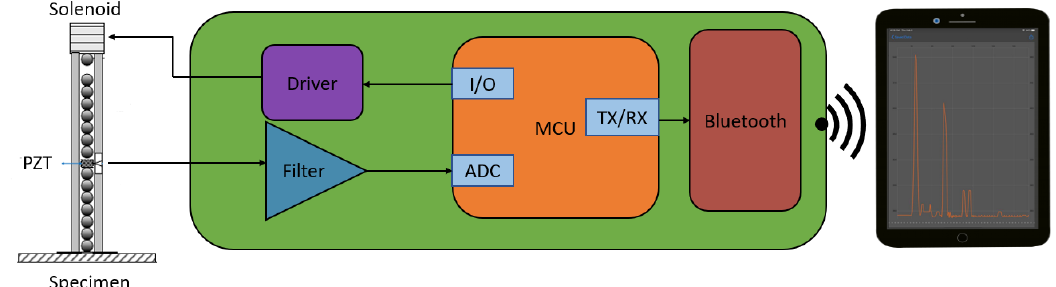
Figure 2. Schematics of the overall HNSW wireless sensor node. The “specimen” in the figure representsany material / structure to be monitored using the solitary waves.